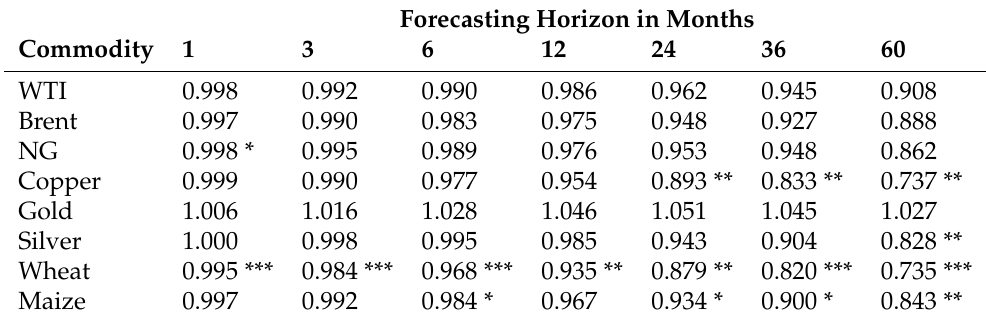
Table 5. RMSFE ratio for real commodity price AR(1)-based